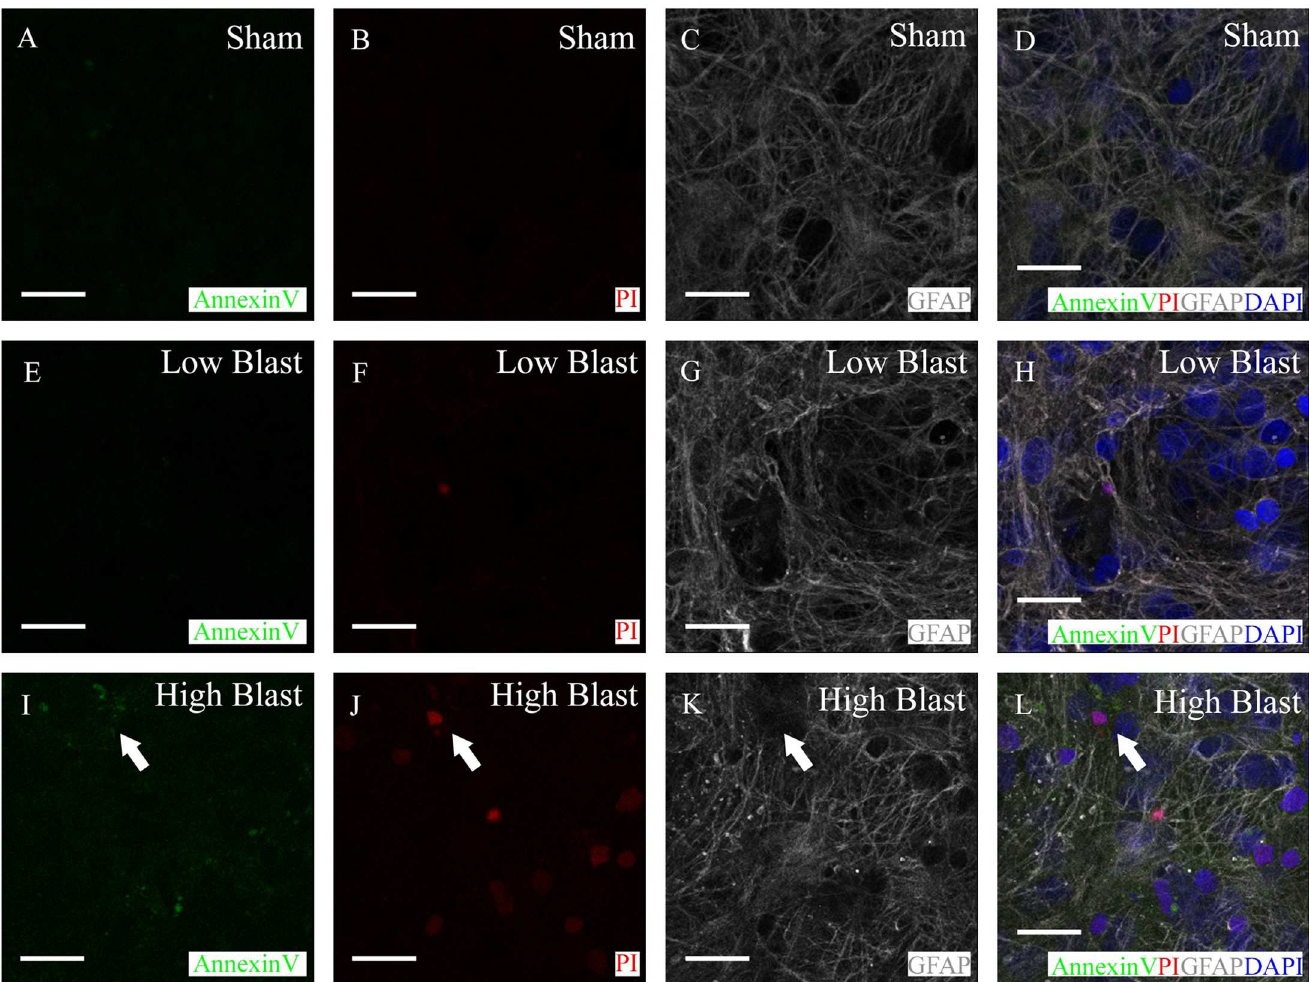
Fig 2. Limited early apoptotic death of astrocytes following blast exposure. At 2 h followinginjury, AnnexinV conjugatedto Alexa 488 (green; A, E, I) was used to identify apoptotic cells in sham control (A-D), low-blast(E-H), and high-blast (I-L) groups. Sampleswere additionallylabeledwith the cell death marker PI (red; B, F, J), an antibody againstGFAP (gray; C, G, K), and DAPI (blue). Overlay of AnnexinV, PI, GFAP, and DAPI staining (D, H, L). AnnexinV positive cells (arrow) were infrequent in all three experimental groups. Almost none of the observedAnnexinV positive cells were co-labeled with GFAP. Scale bars 20 μ